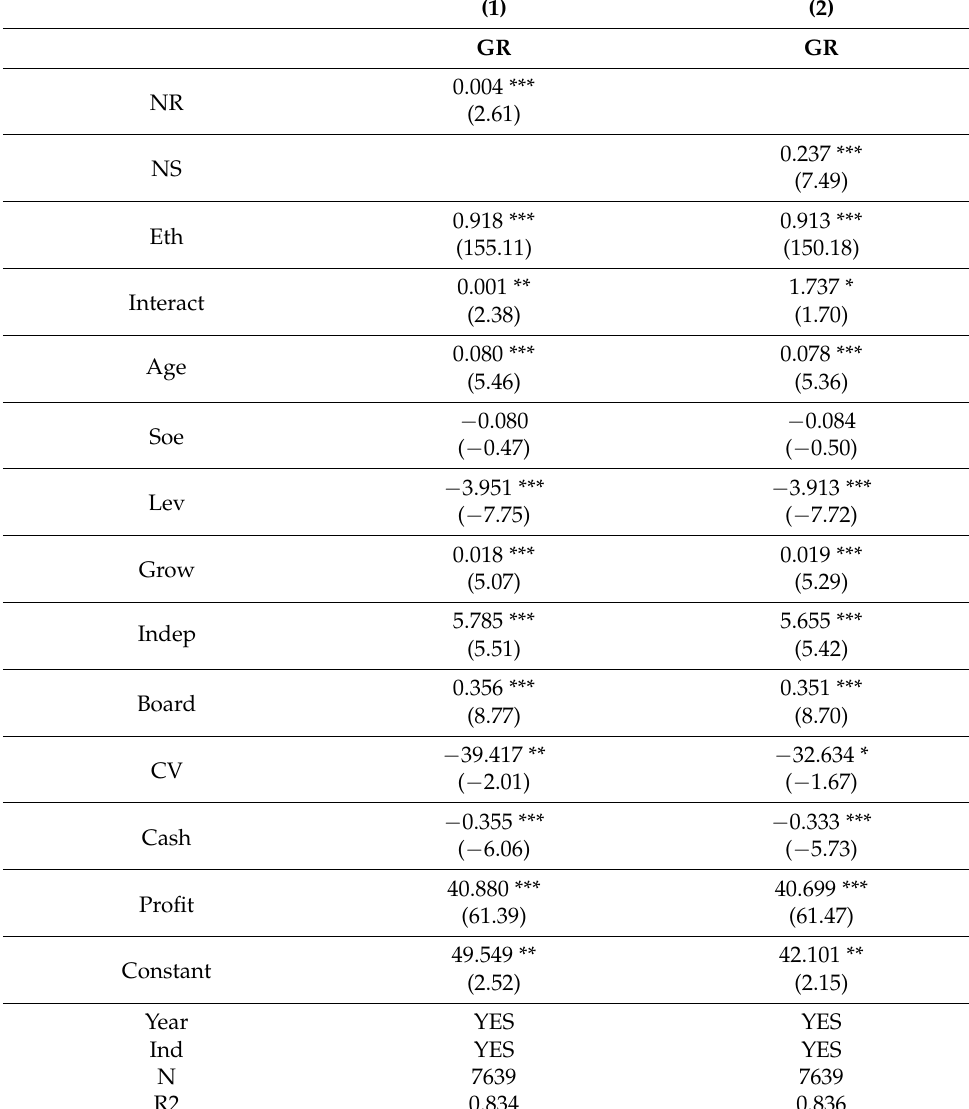
Table 6. The results of moderating effect